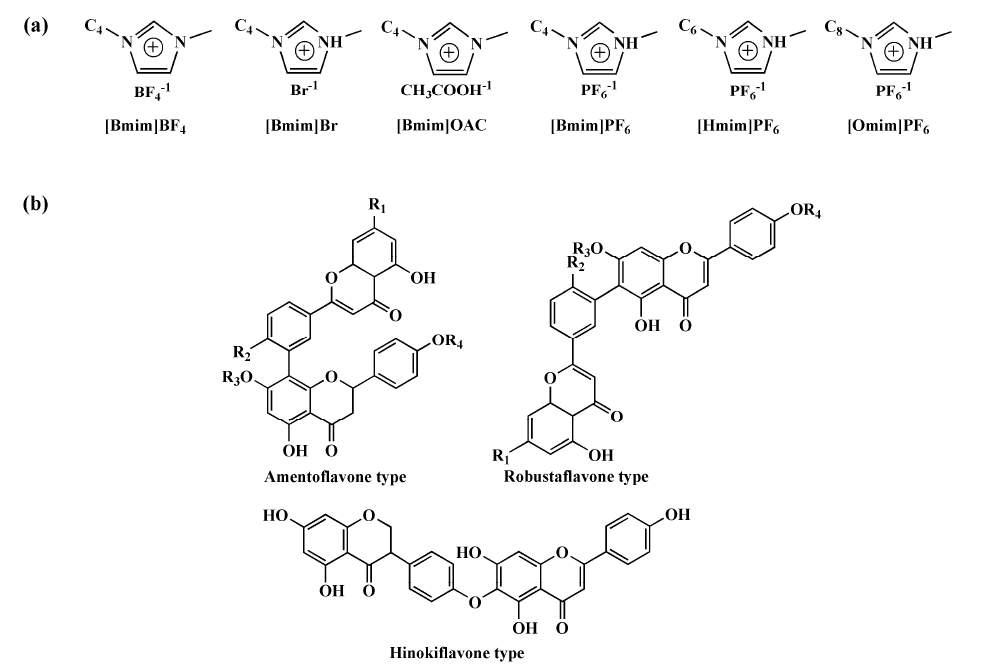
Figure 1. Chemical structures for ILs ( a ); Chemical structures of bioflavonoids in Selaginella doederleinii ( b ). Anti-tumor effect is an important pharmacological activity of S. doederleinii . Acording to Kos μ ge reported [15], the ethanol extract in S. doederleinii could inhibite the growth of ehrlich ascites tumor of mice in vivo and vitro experiments. Lee [16] found that the methanol extracts from S.doederleinii showed strong inhibition effects against colon cancer cells, bronchoalveolar cancer, and chronic myeloid leukemia in vitro. Moreover, anti-tumor activity of the methanol extracts was far higher than that of ellipticine as a positive reference.